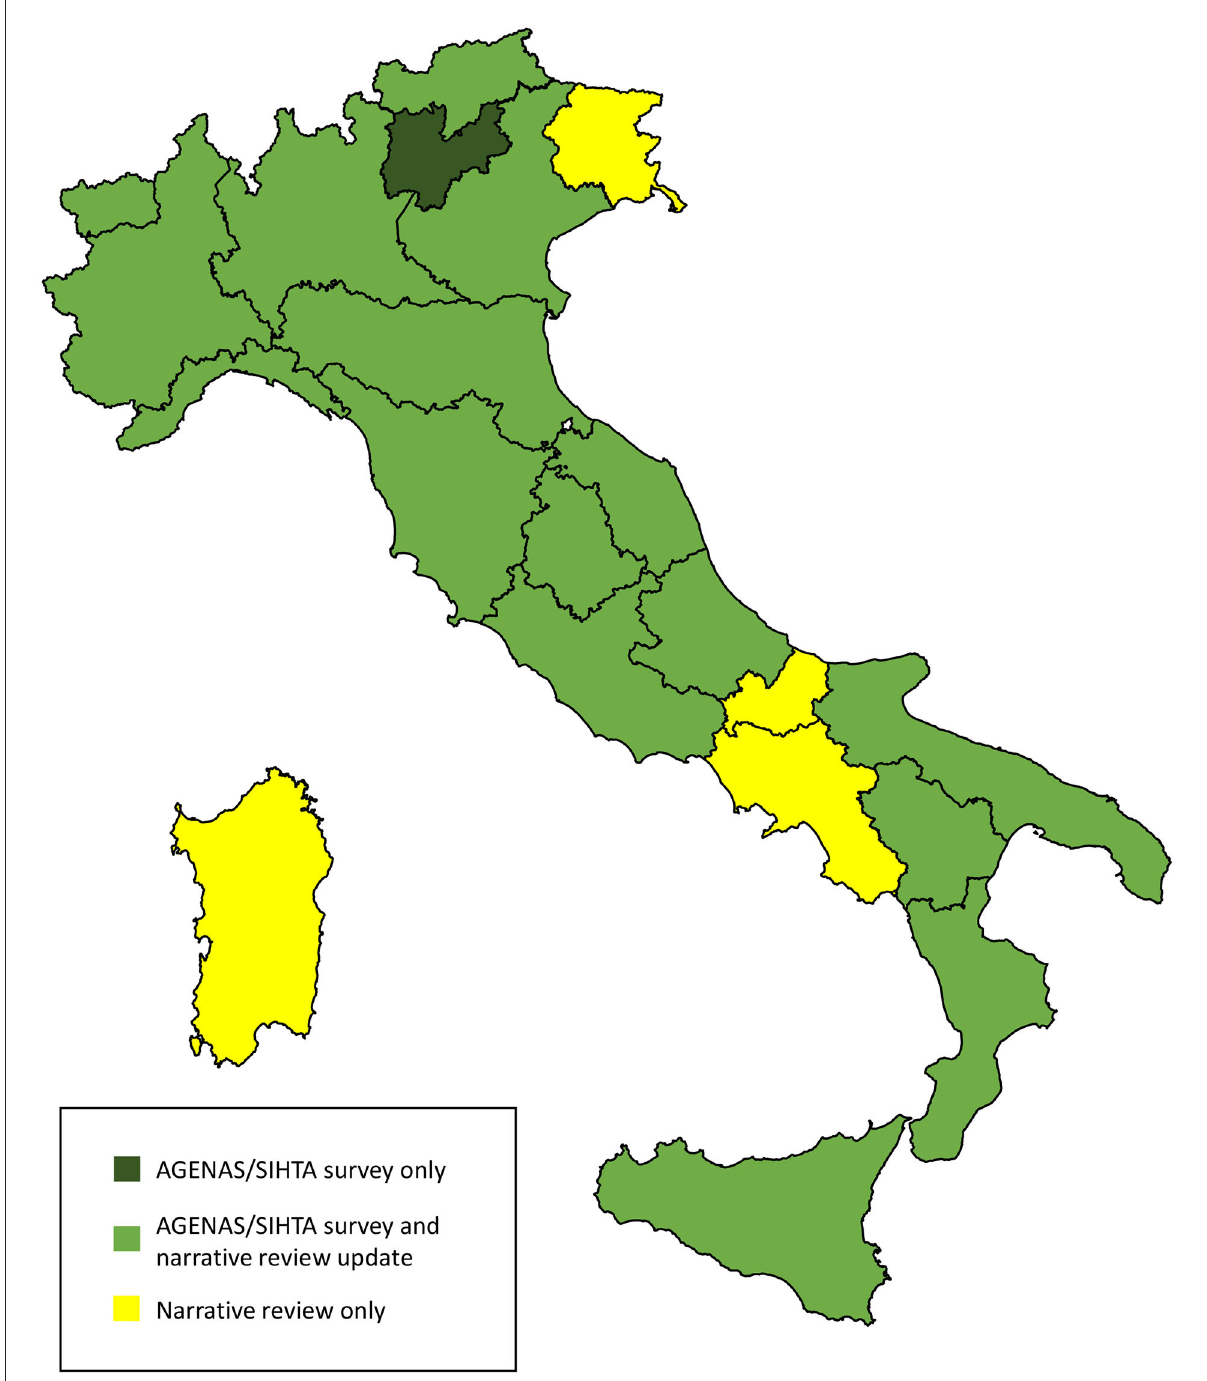
FIGURE1 Source of information on the state of HTA in the Italian Regions. The map was adapted from the Italian National Institute of Statistics https:// www.istat.it/storage/cartografia/confini_amministrativi/generalizzati/Limiti01012021_g.zip.